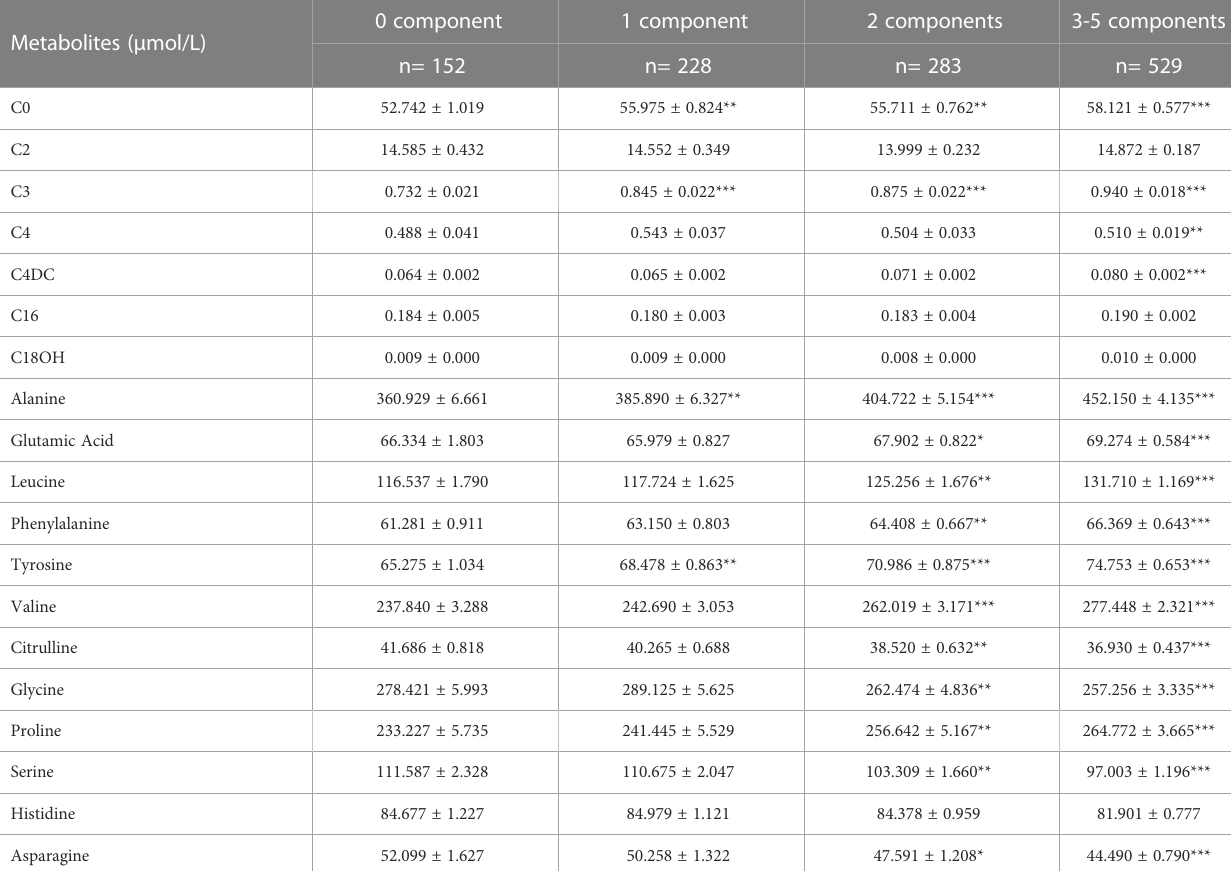
TABLE 2 The levels of amino acids and acylcarnitines in different groups according to the number of metabolic syndrome components.